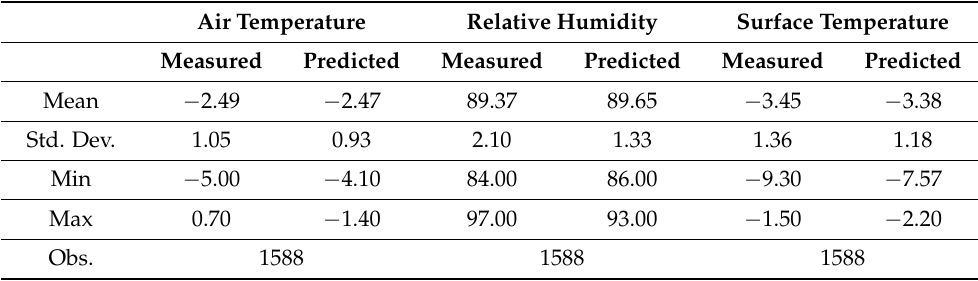
Table 1. Descriptive statistics of weather